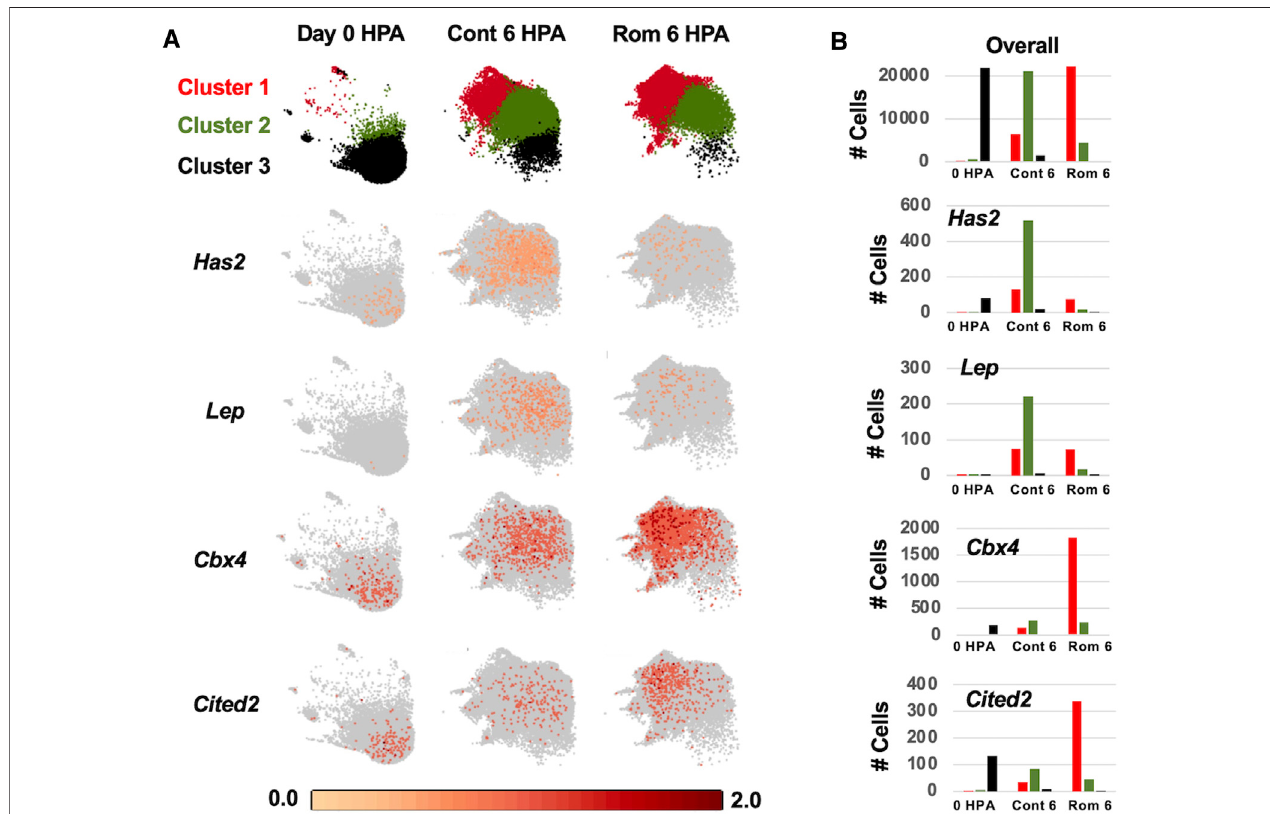
FIGURE5| Log 2 expressionofregenerationassociatedgenesamongcontrol0HPA,control6HPA,andromidepsin6HPAsamplesforclusters1 – 3. (A) At0HPA, the majority of cells were observed in cluster 3 (black). At 6 HPA, there were few cluster 3 cells and the proportion of cluster 1 (red) and cluster 2 (green) cells varied between the control and romidepsin-treated samples. Has2 and Lep were expressed more highly in Cont 6 HPA while Cbx4 and Cited2 were expressed more highly in Rom 6 HPA. (B) Number of cluster 1-3 cells expressing Has2 , Lep, Cbx4 , and Cited2 among samples.